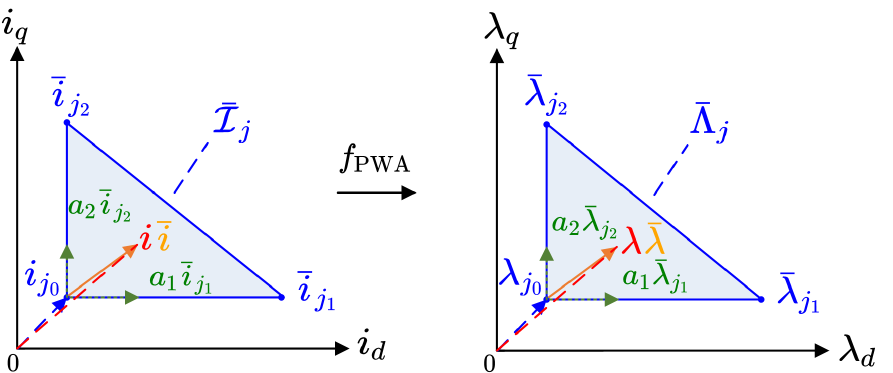
Figure 6. Visualization of f pwa : ( left ) current simplex (triangle) ¯ I j shifted by i j 0 vector and ( right ) corresponding flux simplex (triangle) ¯ Λ j shifted by λ j 0